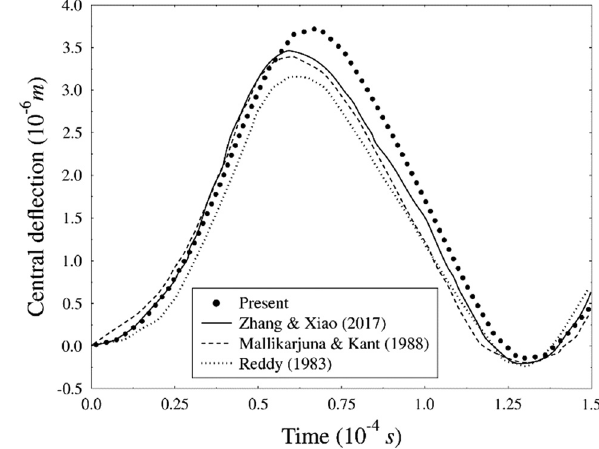
Figure 5: Comparison of linear dynamic responses of square lami - nated [ 0°/90°/0° ] clamped plate.